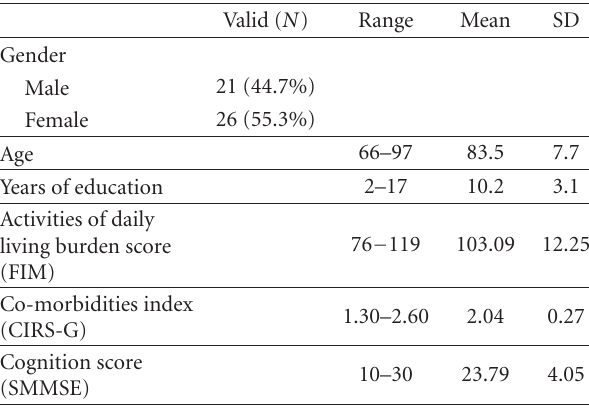
Table 1: Description of